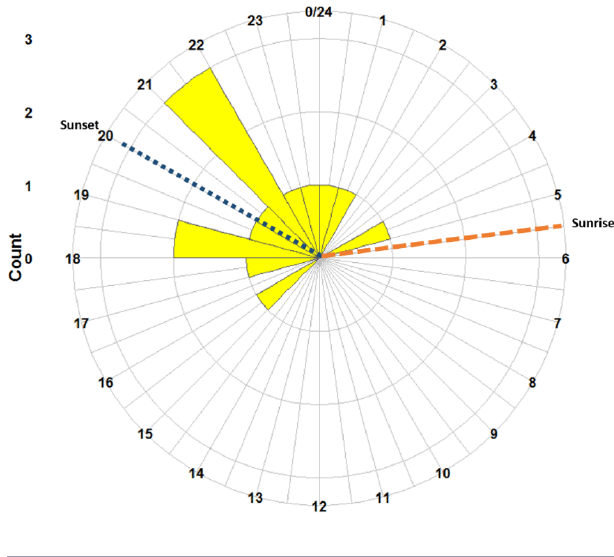
Fig. 4 . Diel variation (hrs, in local time) in arrival times of Common Terns ( Sterna hirundo ; n = 14) from three nesting colonies in the northwest Atlantic (Petit Manan Island, Maine, USA; Country Island, Nova Scotia, Canada; and Sable Island, Nova Scotia, Canada) at staging areas in Nantucket Sound, Massachusetts, USA during 2013. Dashed lines show local times of sunrise (orange) and sunset (blue).